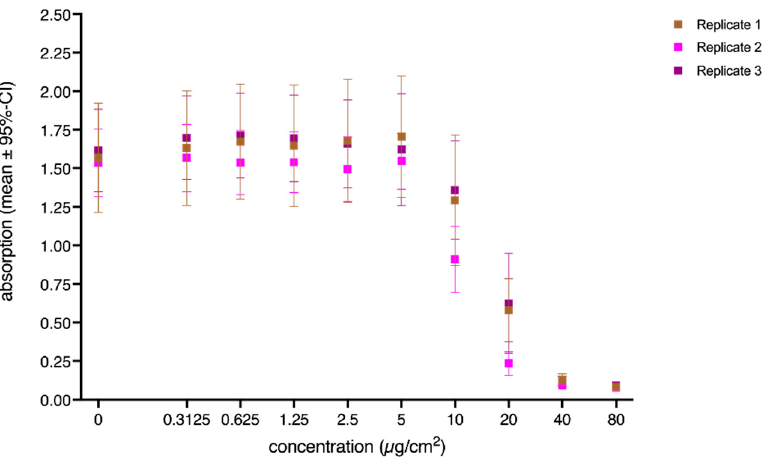
Figure 4. Concentration-dependent effects of the random factor replicate on the absorption. Values represent mean values (corrected absorption) of the three biological replicates. Error bars indicate the corresponding 95% confidence intervals. The concentration is the administered concentration of the ENMs based on the initial dispersion.